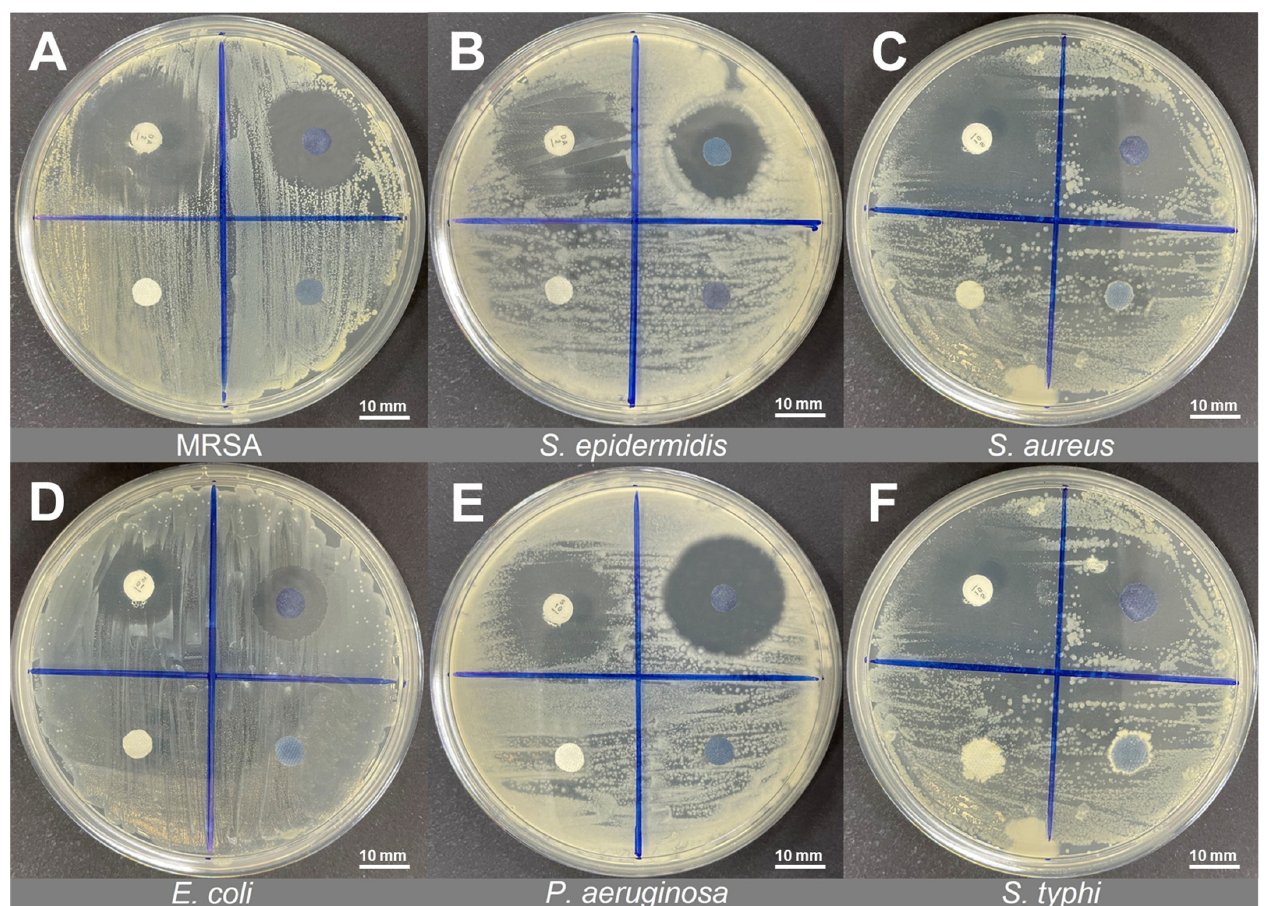
Figure 3. The inhibition zone revealed by bare PES fabric (BF), deprotonated/undoped PANI fabric (UF), protonated/doped PANI fabric (DF), and antibiotic (AB) disc control against ( A ) MRSA, ( B ) S. epidermidis , ( C ) S. aureus , ( D ) E. coli , ( E ) P. aeruginosa , and ( F ) S. typhi . Table 3. Inhibition zone of protonated PANI fabrics in contact with all selected bacteria. Type of